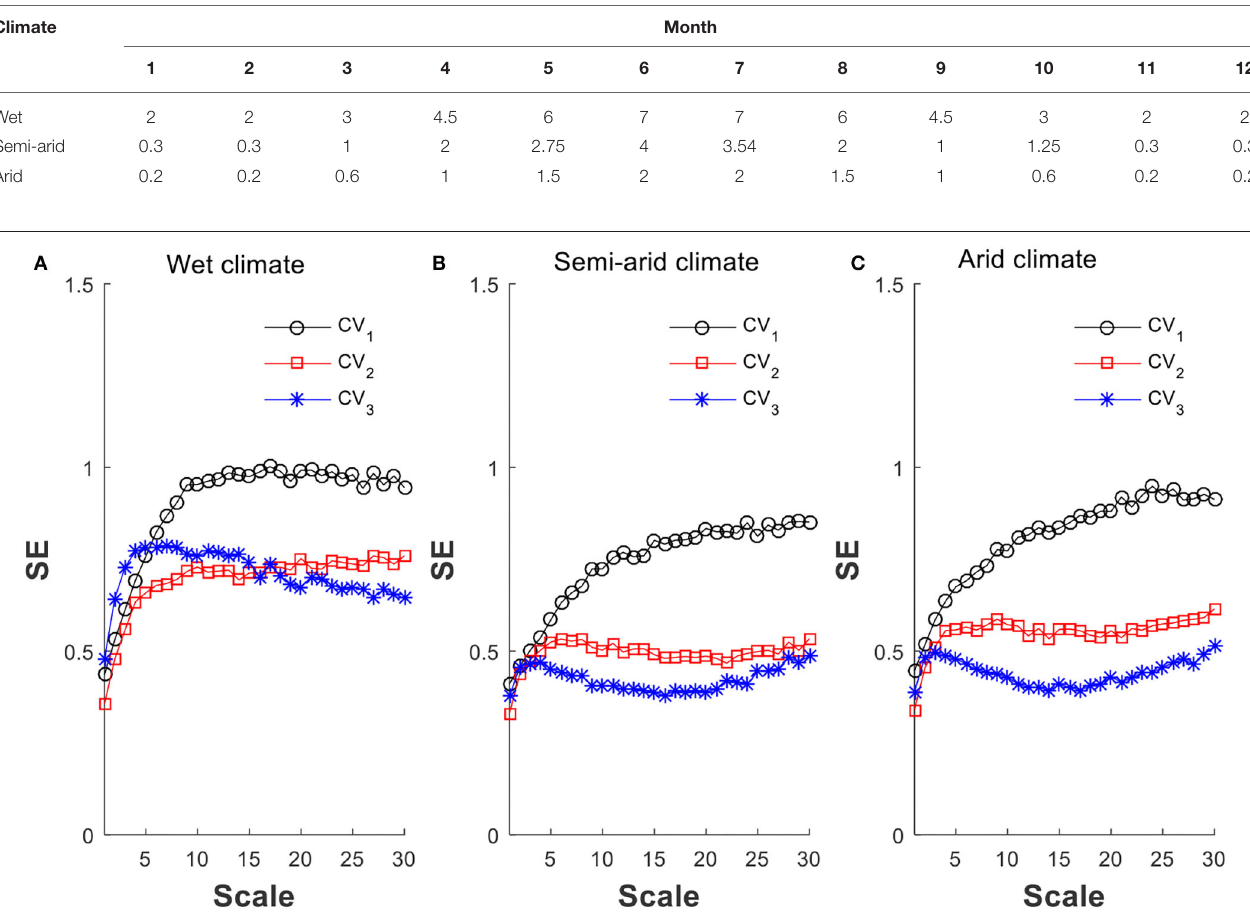
FIGURE 11 | The shift of MSE patterns per the variation of µ X and CV X : (A) wet climate, (B) semi-arid climate, and (C) arid climate. Three cases of variation in daily CV X : Case 1, asterisk, constant CV X monthly µ X